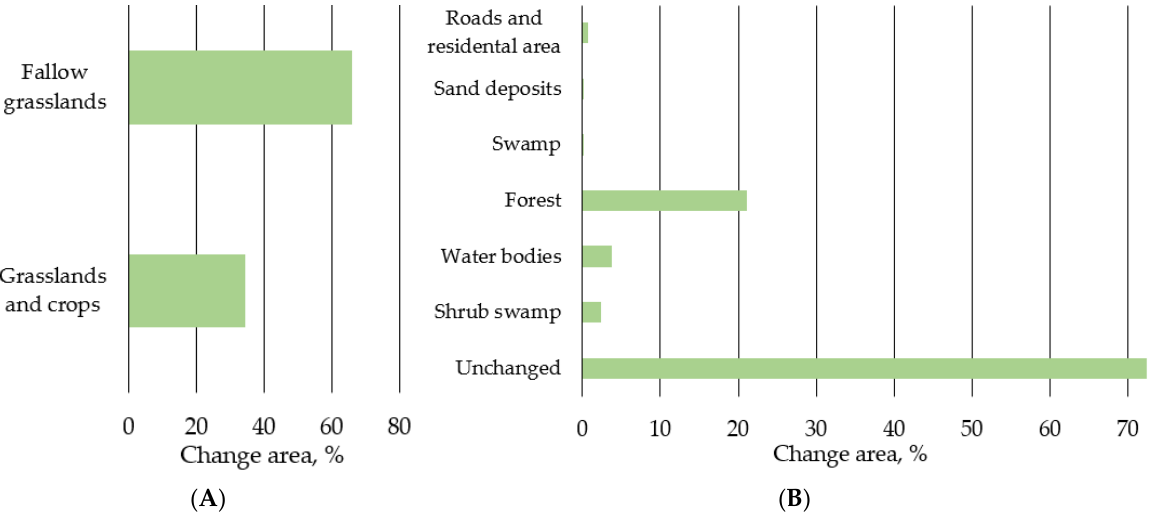
Figure 7. Grassland dynamics over a 47-year time period, according to a comparison of the CORONA (1972) and Sentinel-2A (2019) missions: ( A ) state of grasslands in 2019 with tree and shrub vegetation reduction after 1972; ( B ) proportion of grasslands transformed into other types of landscapes.